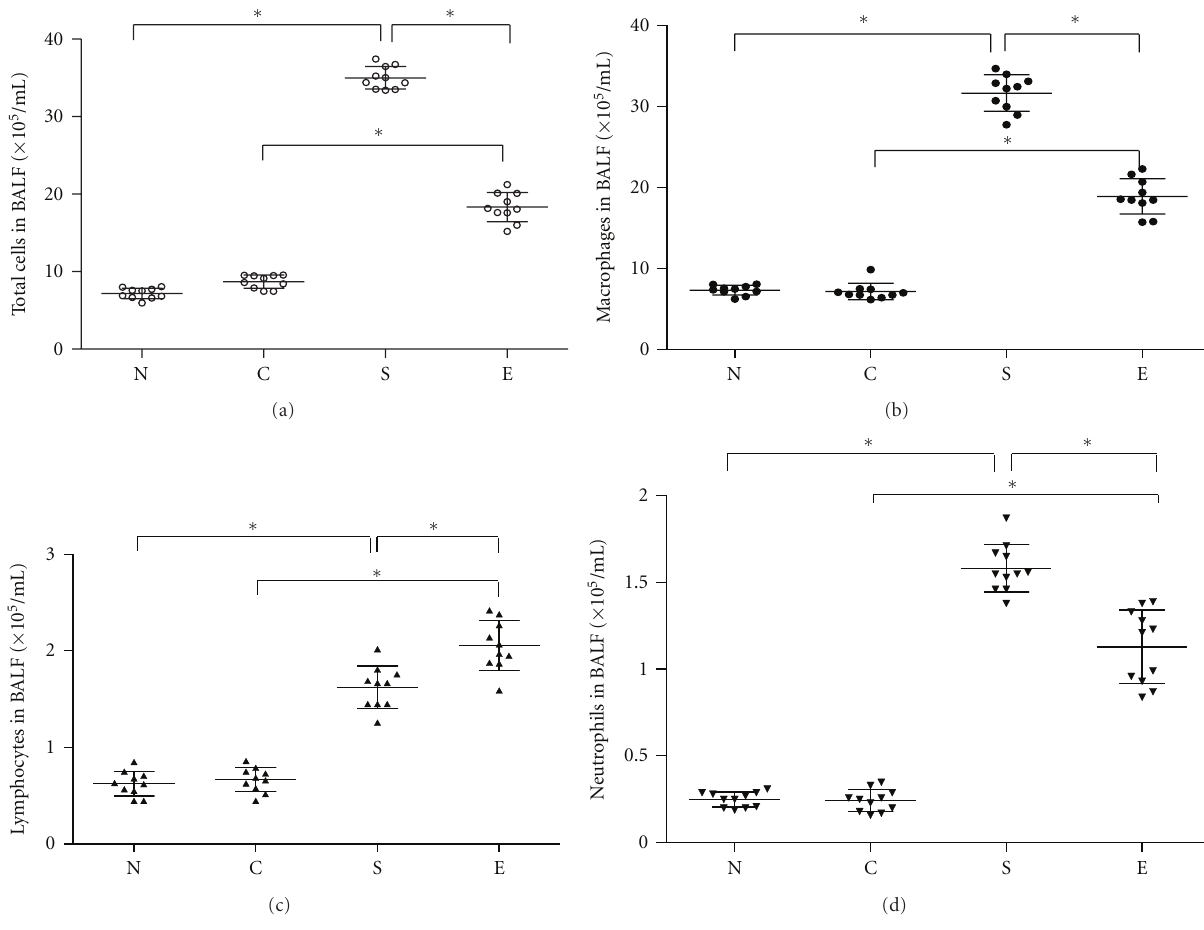
Figure 2: Treatment with erythromycin reduces the numbers of inflammatory infiltrates in the lungs of rats. BALF samples were collected from individual rats and the cells were stained with May-Gr¨unwald-Giemsa. The numbers of total inflammatory infiltrates, macrophages, lymphocytes, and neutrophils were analyzed, according to their morphological characters. Data are expressed as mean numbers of individual samples and mean values (lines) for each group ( n = 10). Group N: rats exposed to regular air without any special treatment; Group C: rats exposed to regular air and were treated with erythromycin; Group S: rats exposed to smoking air and were treated with saline; Group E: rats exposed to smoking air and were treated with erythromycin daily for nine weeks beginning at the forth weeks smoking. ∗ P < 0 . 05.